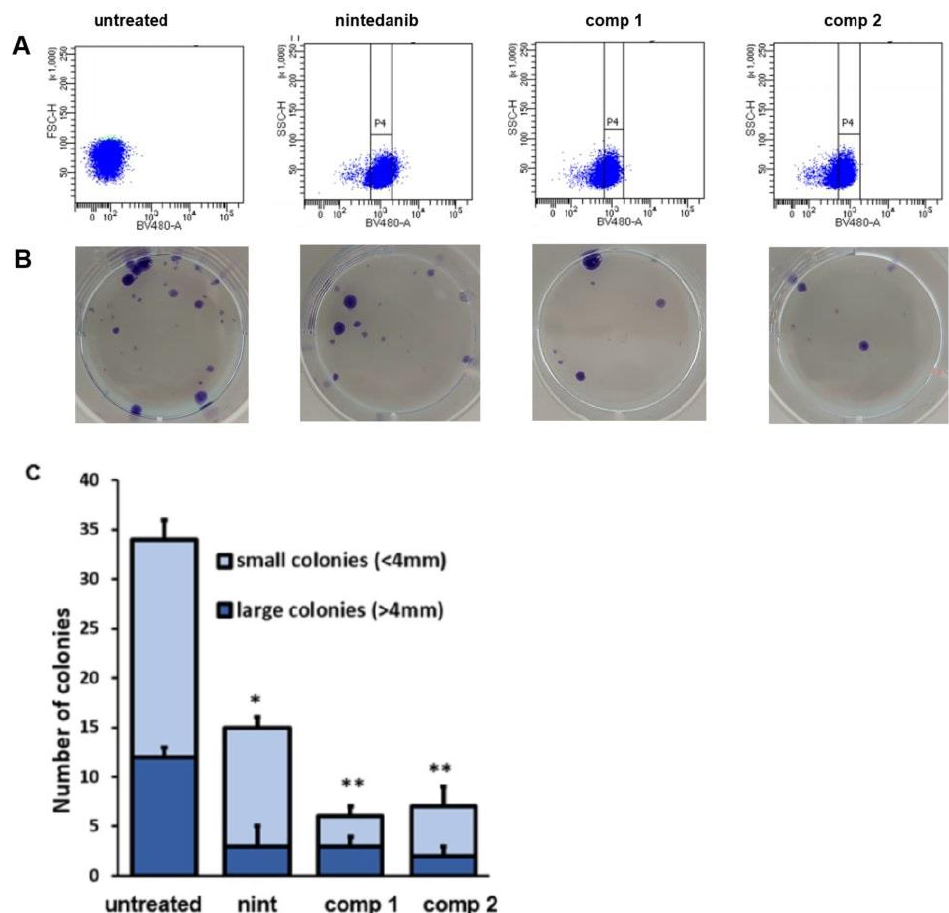
Figure 10. Inhibition of clonogenic activity. TGF β -treated A549 cells were grown in the presence of nintedanib or compounds 1 or 2 for 24 h. ( A ) After incubation, cells were sorted (BDMelody) and iso- lated cells from the selected population (indicated as P4) were seeded at low density (1000 cells/6 well petri dishes). ( B ) Number of colonies obtained after 2 weeks growth in standard media. ( C ) Quan- tification of colonies. Data are representative of three independent experiments. * p < 0.05 and ** p < 0.001 vs. untreated cells.